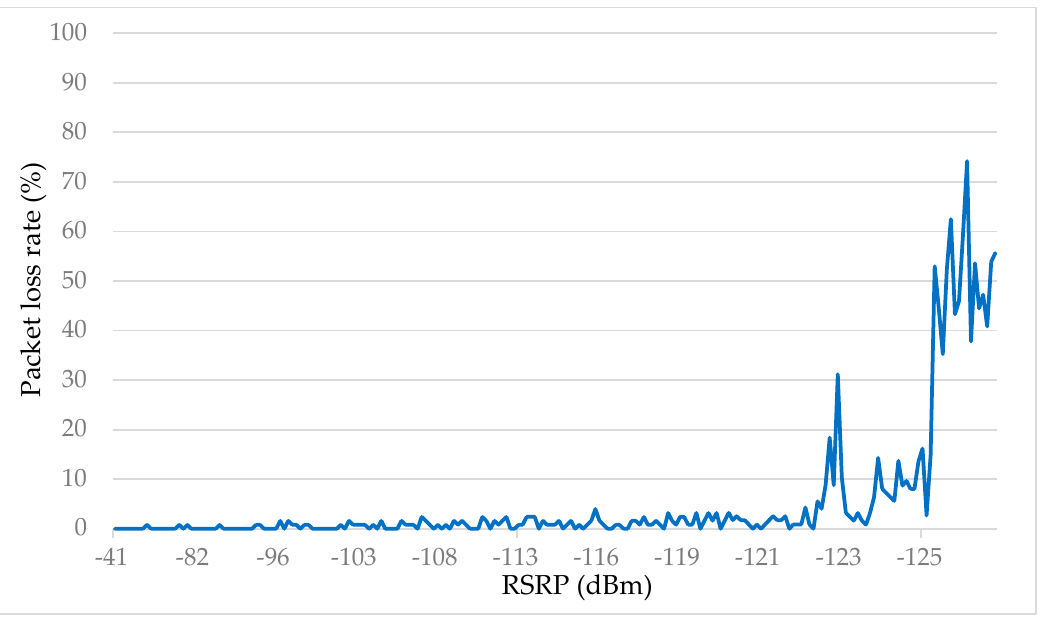
Figure 6. The relationship for packet loss rate and RSRP from UE.